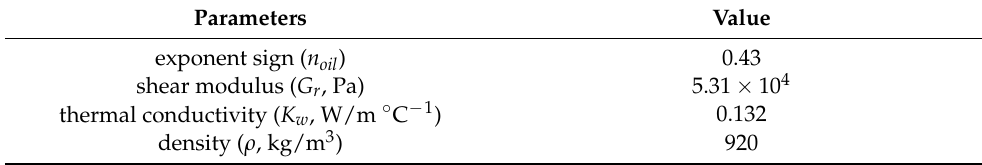
Table 2. Basic parameters of the lubricating